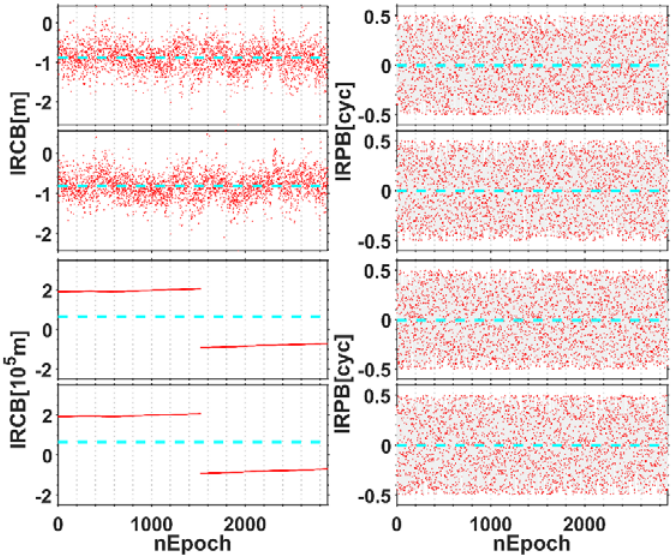
Figure 4. Estimation results for inter-receiver code bias (IRCB) and IRPB under non-common clock mode. The panels from left to right are the IRB for UB380 receiver and K708 receiver. The subplots from top to bottom correspond to IRCB and IRPB at B1 and B2 frequency, and the blue-green dotted line is the corresponding mean of